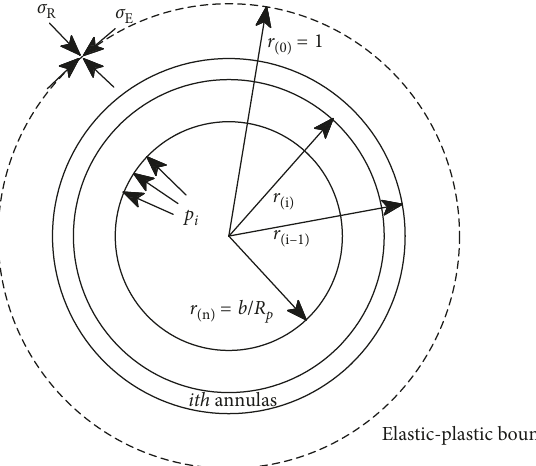
Figure 3: Normalized plastic zone with finite number of annuli.